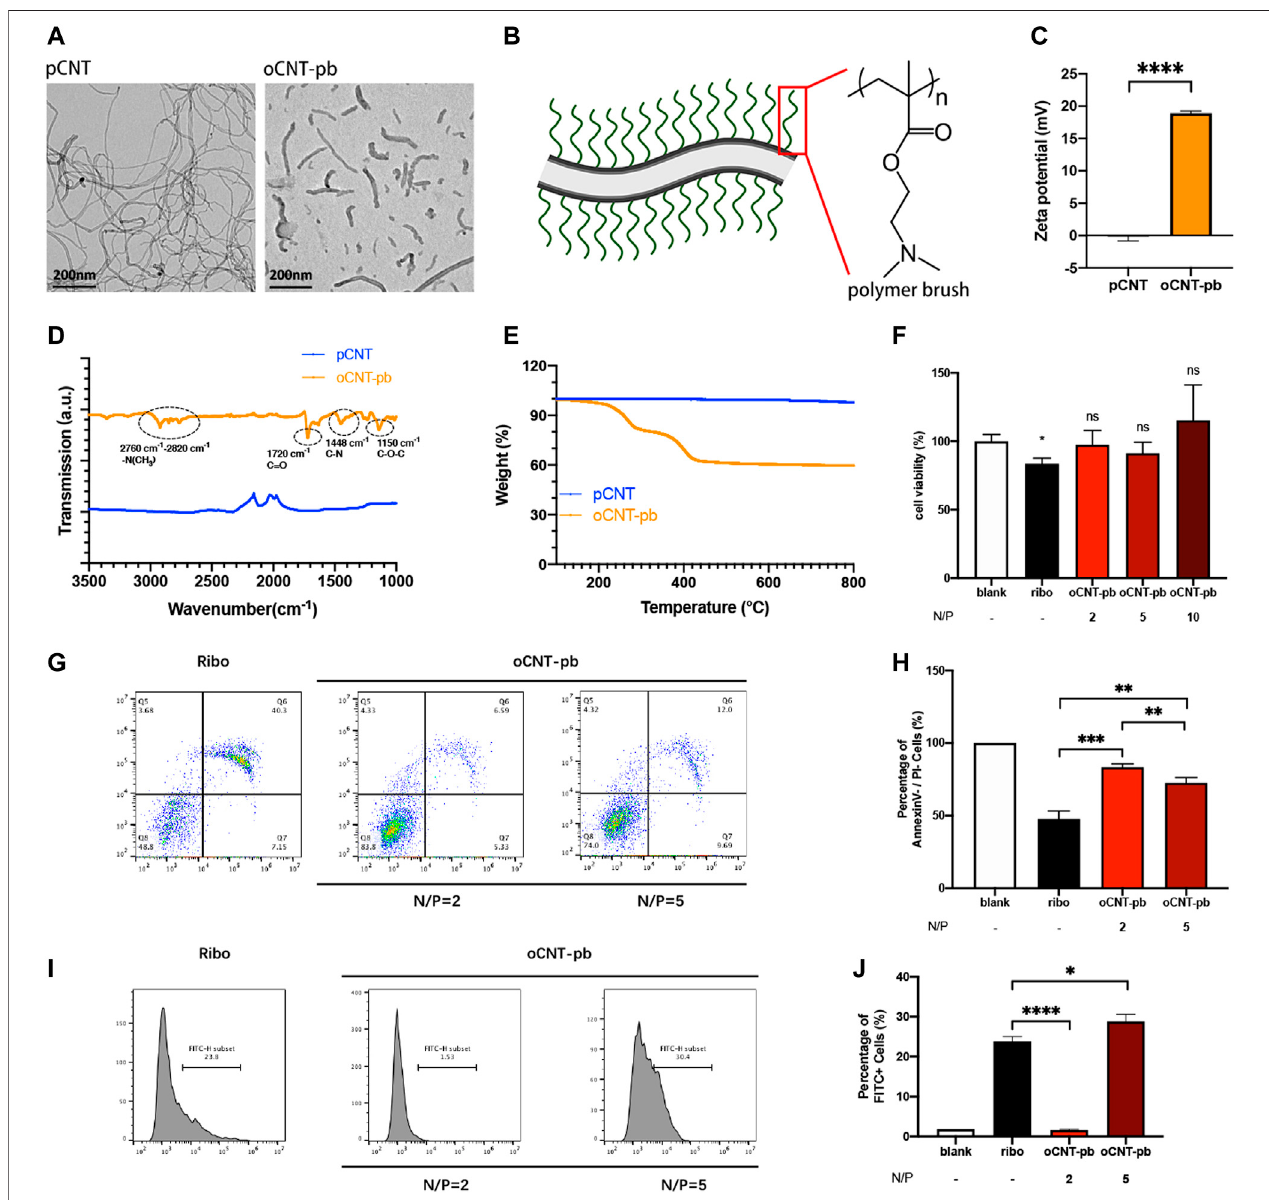
FIGURE3| CharacterizationofoCNT-pb. (A) TEMimageofpCNTandoCNT-pb. (B) SchematicdiagramofoCNT-pbandthechemicalstructureofpolymerbrush. Scale bar: 200 nm (C) Zeta potential measurements of pCNT and pCNT-pb in 10 mM PBS. (D) FTIR of pCNT and pCNT-pb with wavenumber range from 1000 to 3500 cm − 1 . (E) TGA of pCNT and oCNT-pb measured from 150 to 800 ° C. (F) The cytotoxic effect of oCNT-pb at various concentrations and Ribo transfection reagent on NPCs for 6 h was determined using aCCK8 assay. PBS was used as control. (G) Flow cytometry pro fi le and (H) percentage of apoptosis ofNPCs treated with oCNT-pbatvariousconcentrationsandRibotransfectionreagentfor6 h. (I) Flowcytometrypro fi leand (J) percentageofFITCpositivecellsafterNPCsweretransfected with Fam-labeled control siRNA by oCNT-pb at various concentrations and Ribo transfection reagent for 6 h. Quantitative results are shown as the mean ± SD (n (cid:1) 3). * p < 0.05, ** p < 0.01, ** p < 0.001, **** p < 0.0001.